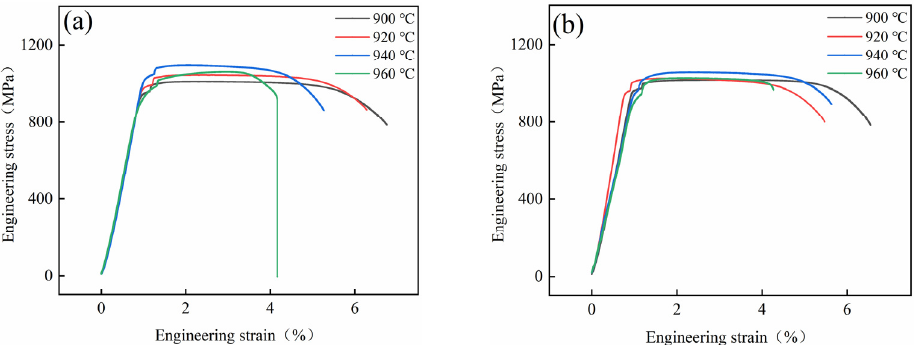
Figure 11. Engineering stress–strain curves after BASC and BASCA heat treatment: ( a ) BASC heat treatment; ( b ) BASCA heat treatment.